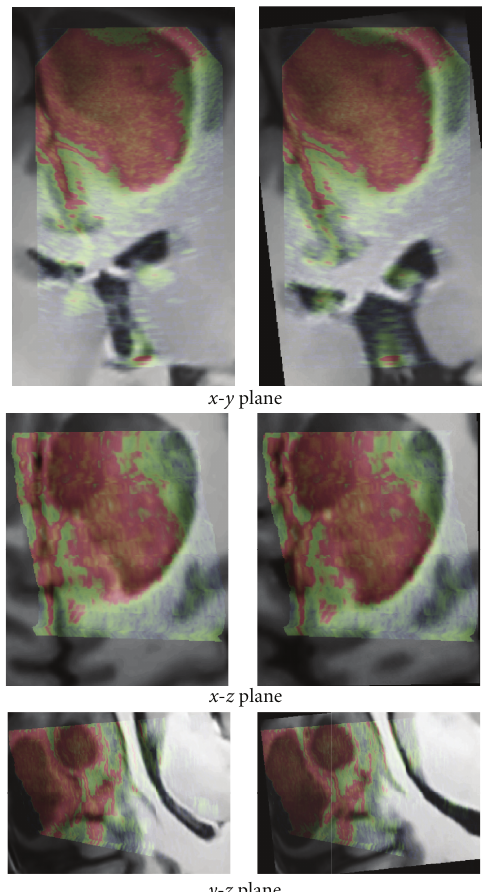
Figure 7: Patient 3. Left: registration given by the neuronavigation system. Right: the result after correction with our registration approach. The low intensities of US images are in green and the high in